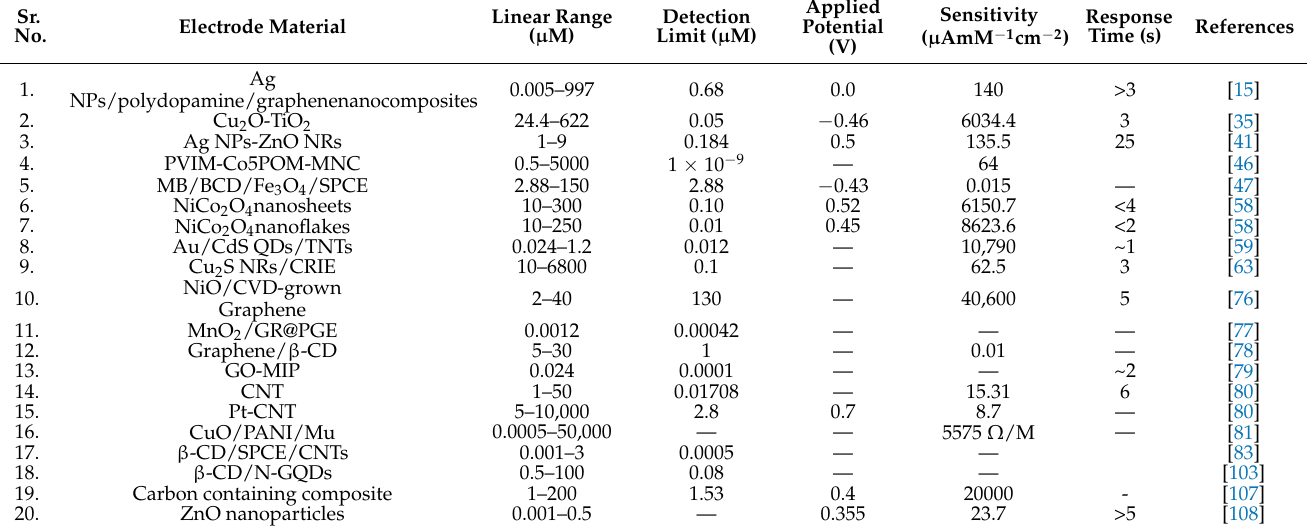
Table 1. Performance comparison of various non-enzymatic electrochemical biosensors for the determination of